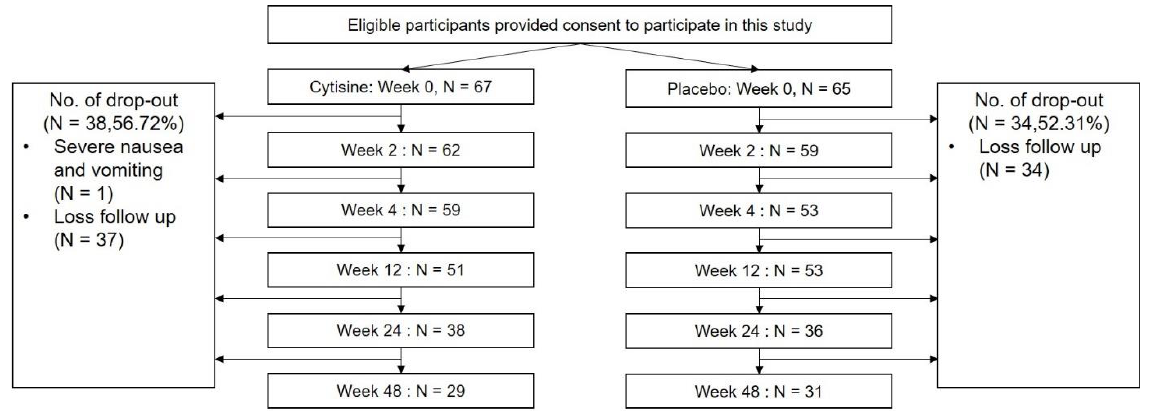
Figure 2. A Flow of participants.